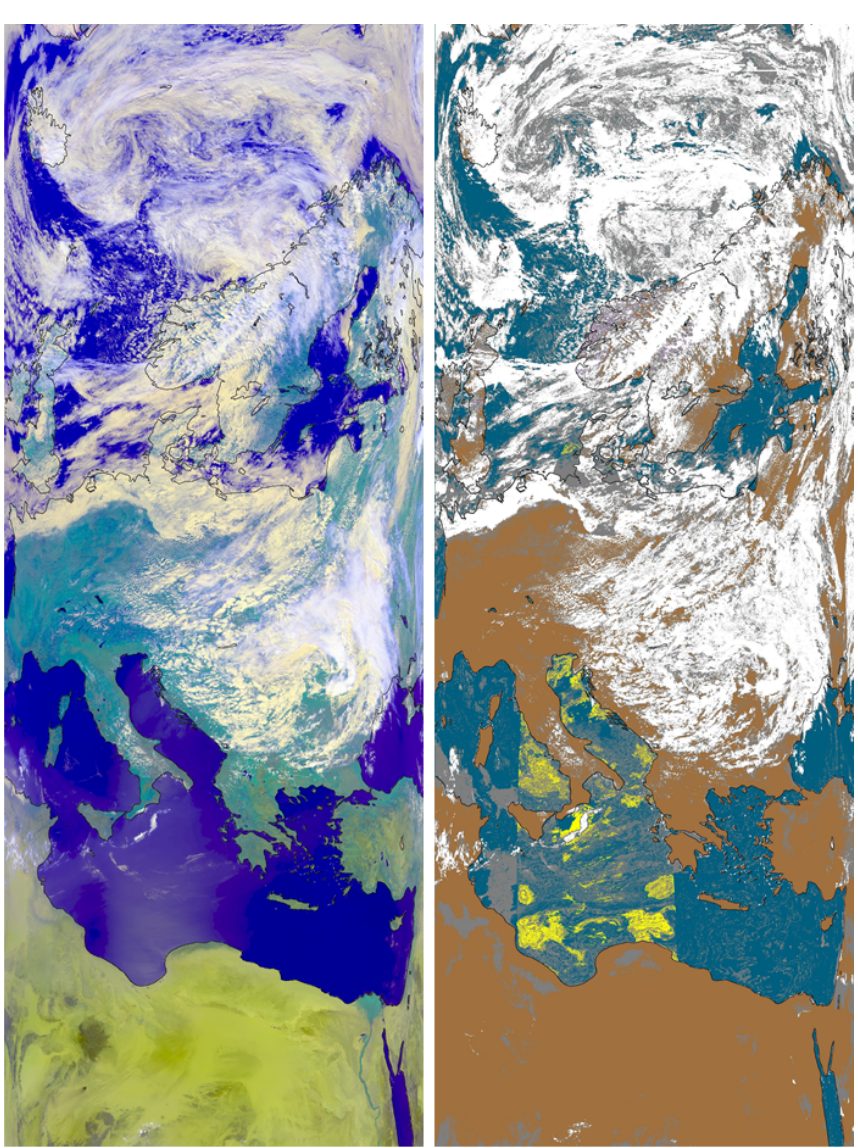
Figure 4. RGB composite and cloud mask in the traditional APOLLO quicklook style (Kriebel et al., 2003; see also text for color description) from AVHRR on NOAA-18 for 15 July 2008 in orbit